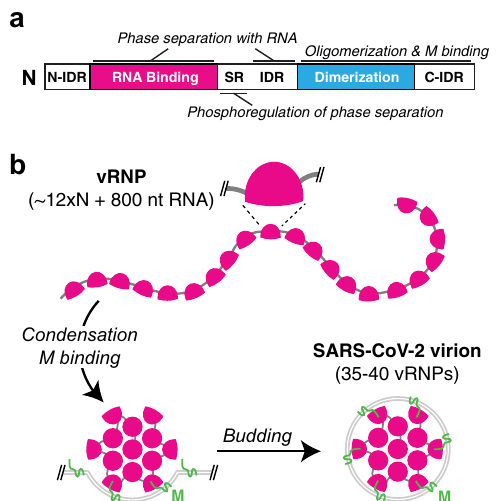
Fig. 8 Model for SARS-CoV-2 virion assembly. a Domain organization of SARS-CoV-2 N protein, with domains responsible for phase separation with RNA (RNA-binding domain and central IDR) and M protein (C-terminal domains) marked. Our data and related work suggests a role for phosphorylation of the SR-rich region in regulating the gel vs. liquid behavior of N + RNA condensates 55 . b Proposed assembly mechanism of SARS-CoV-2 virions. Viral RNPs with ~12 copies of N and 800 nt RNA coat the genomic RNA, and RNA-driven condensation plus interactions with M drive RNA packaging into virions 33 . Within the virion, individual vRNPs show characteristic orientation on the viral envelope 33 supporting a role for speci fi c N + M interactions in